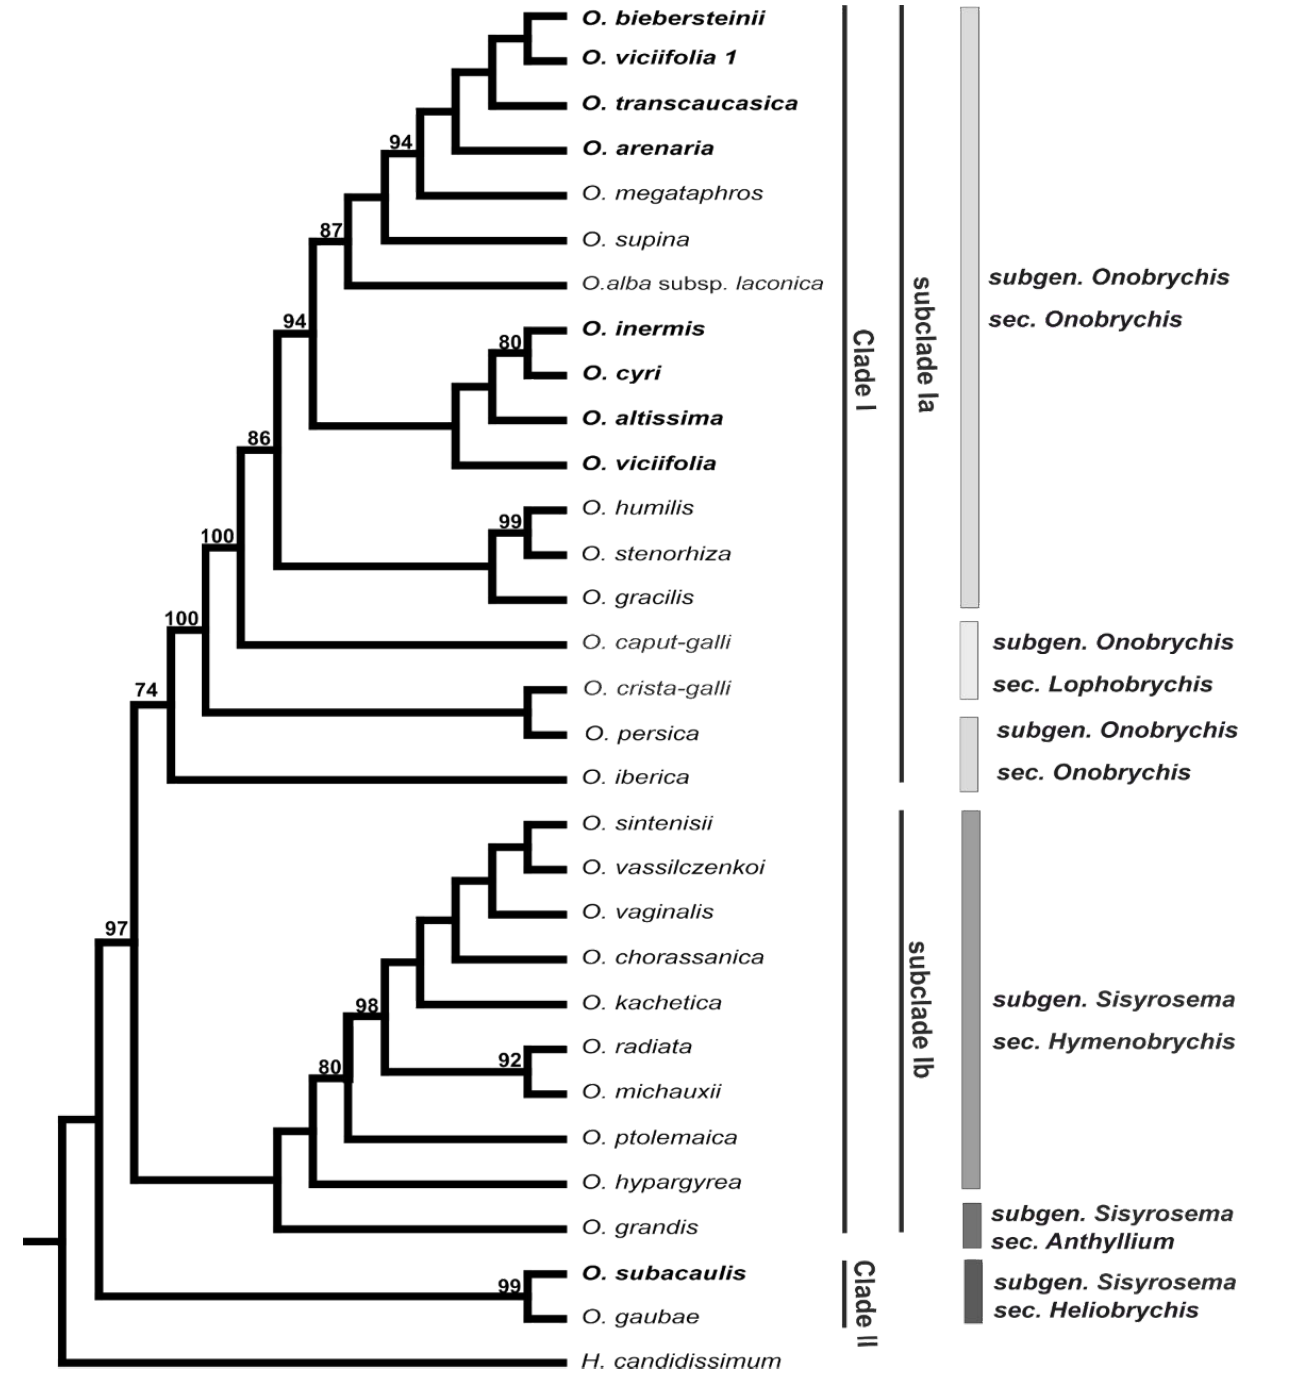
Figure 2. Phylogenetic relationships among analysed Onobrychis species based on the nrITS data set. Bootstrap support values are shown above the branches. The tetraploid species are shown in bold. The tree was rooted with Hedysarum candidissimum.